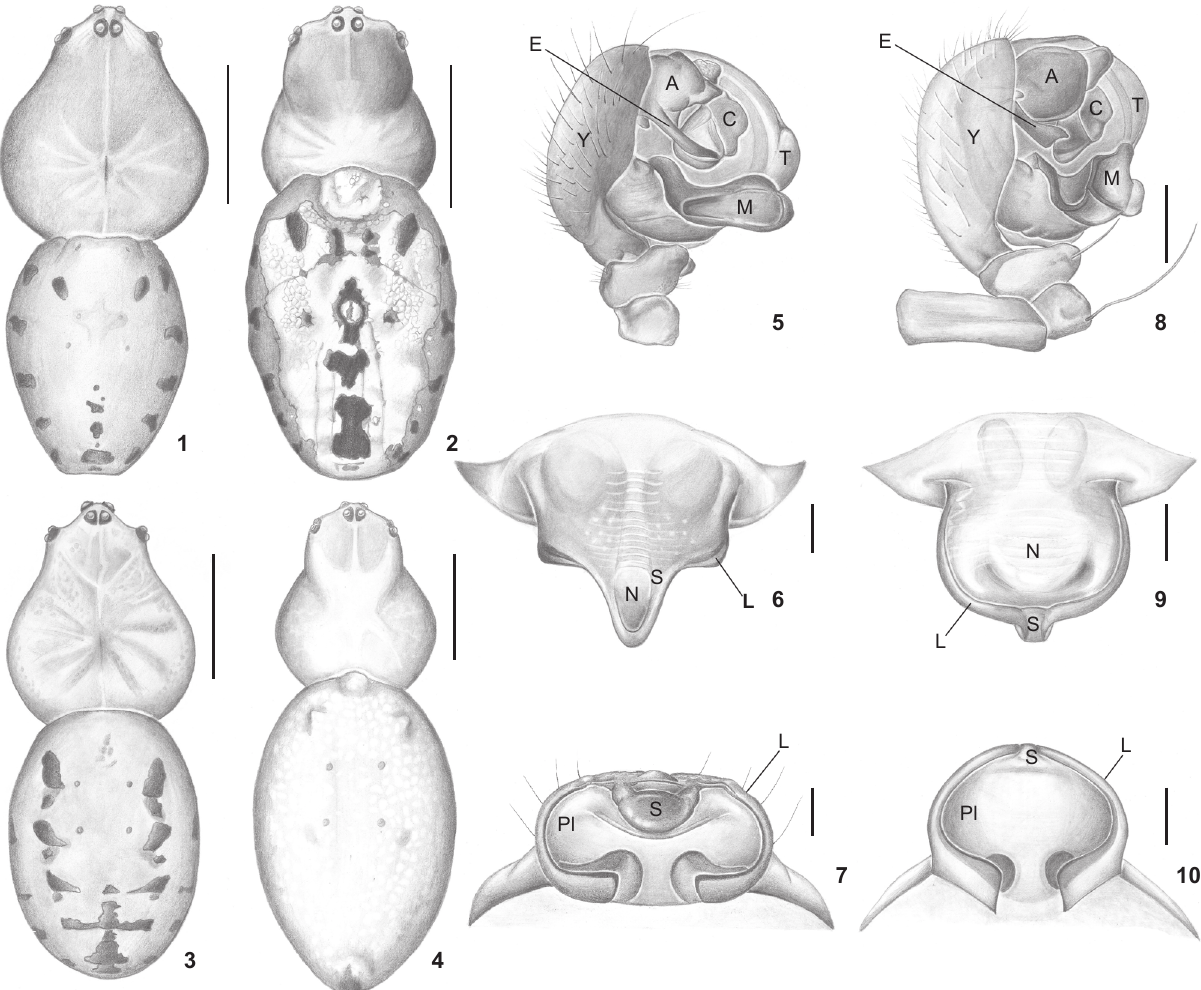
Figures 1-10. (1-2) Alpaida teresinha sp. nov. , habitus, dorsal view: (1) male (holotype); (2) female (paratype). (3-4) Alpaida toninho sp. nov. , habitus, dorsal view: (3) male (holotype); (4) female (paratype). (5-7) Alpaida teresinha sp . nov. : (5) male holotype, palp, ventral view; (6) female paratype, epigynum, ventral view; (7) ditto, posterior view. (8-10) Alpaida toninho sp. nov. : (8) male holotype, palp, ventral view; (9) female paratype, epigynum, ventral view; (10) ditto, posterior view.(A) Terminal apophysis, (C) conductor, (E) embolus, (L) epigynal lip, (M) median apophysis, (N) epigynal notch, (Pl) posterior median plate, (S) scape, (T) tegulum, (Y) cymbium. Scale bars: 0.1